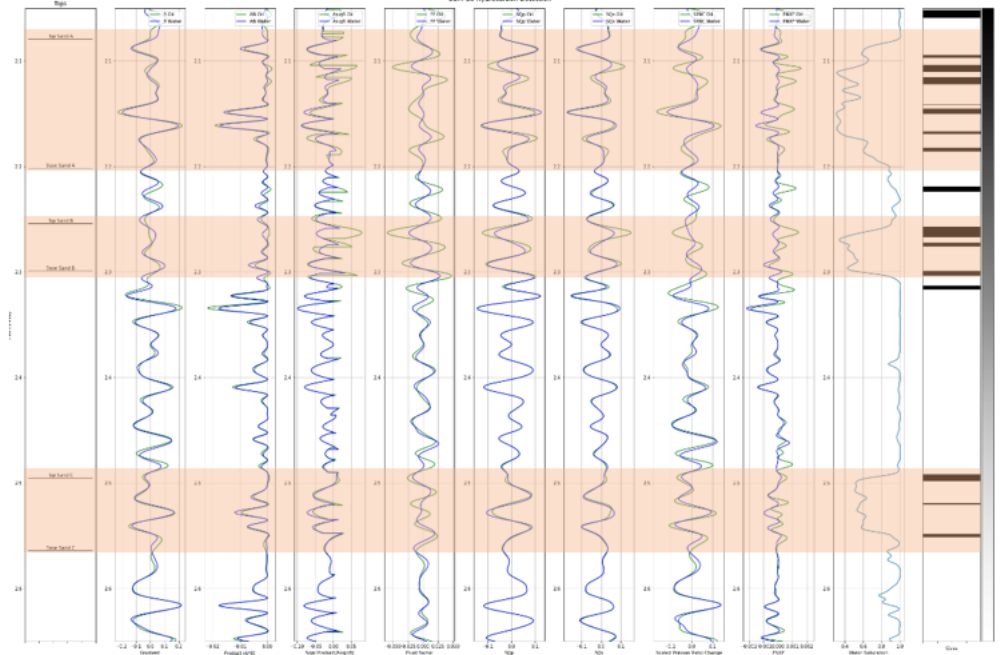
Figure 9. Hydrocarbon delineation result on oil condition.